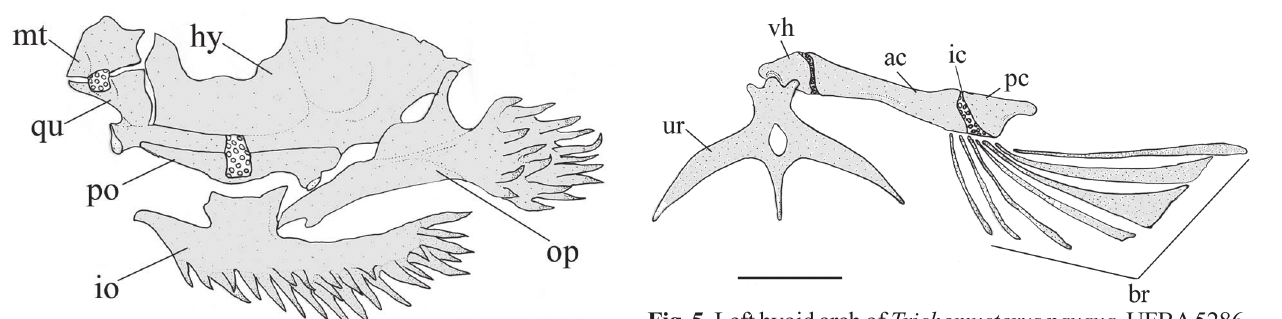
Fig. 5. Left hyoid arch of Trichomycterus payaya , UFBA 5286, paratype, 31.4 mm SL. Ventral view. Abbreviations: ac, anterior ceratohyal; br, branchiostegal rays; ic, interceratohyal